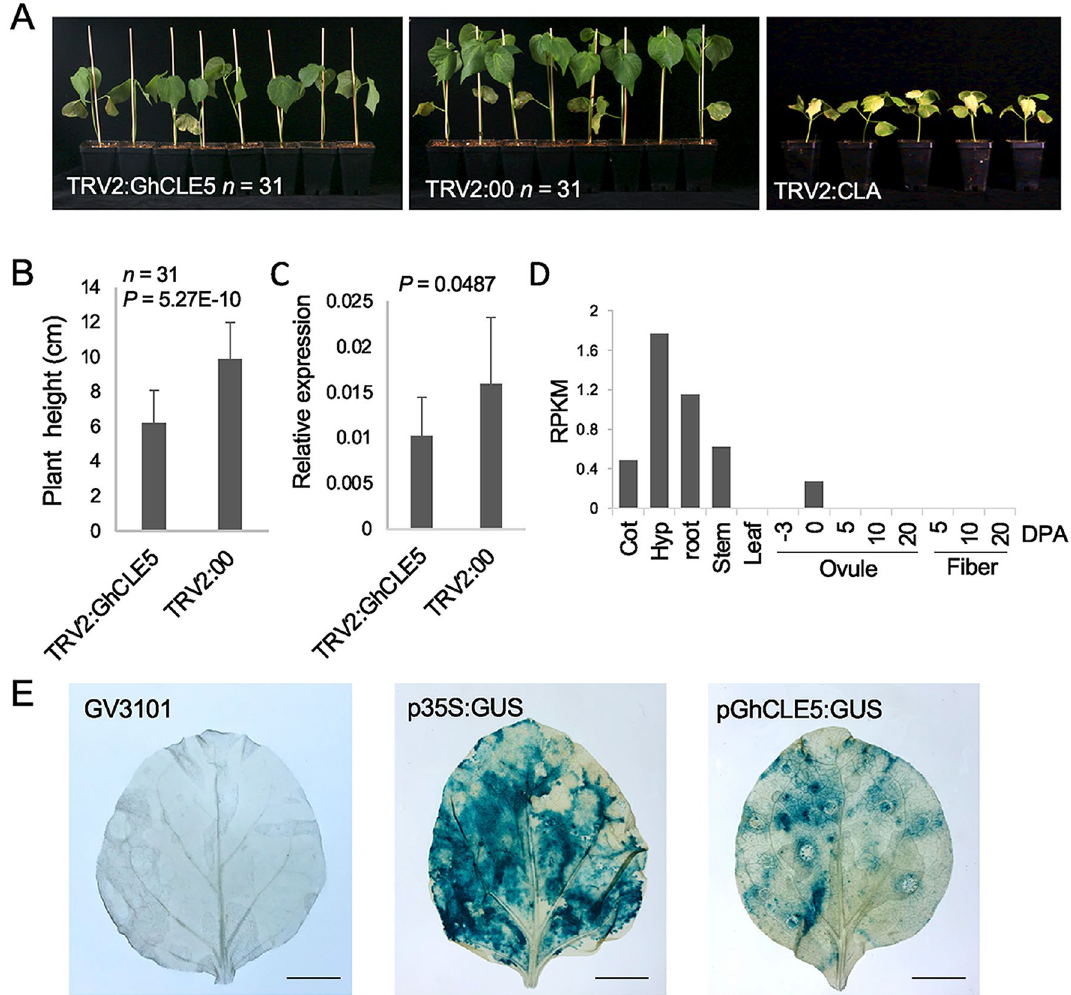
Figure 7. The phenotype of cotton seedlings following VIGS to suppress the expression of GhCLE5 . ( A ) VIGS- treated cotton seedlings. The population sizes of the pTRV2:GhCLE5 and pTRV2:00 treatments were both 31. The pTRV2:CLA was the positive control group for VIGS showing bleached leaves. ( B ) Histogram indicating the differences in plant height between the pTRV2:GhCLE5 and pTRV2:00 groups derived from the VIGS-treated plants shown in panel A (Student’s t test). Error bar = Std. ( C ) Histogram showing the relative expression of GhCLE5 in the pTRV2:GhCLE5 and pTRV2:00 groups derived from the VIGS-treated leaf tissues shown in panel A (Student’s t test). Error bar = Std. ( D ) Histogram showing the GhCLE5 expression pattern in the cotyledon (Cot), hypocotyl (Hyp), root, stem, leaf, ovule, and fiber tissues of upland cotton using RNA-seq RPKM values. DPA, days post anthesis. ( E ) The imagines show the GUS staining of the tobacco leaves transient expressed with the GUS reporter driven by GhCLE promoter (pGhCLE5:GUS). The negative control is GV3101 bacterial injection buffer with and without the pBI121 vector containing a GUS driven by 35S promoter (p35S:GUS). Three biological replicates were applied for each test group. Scale bar = 1 Evolutionary analysis and structure prediction. The screened CLE protein sequences were aligned using ClustalX (http://www.clust al.org/) with default parameters. In constructing the phylogenetic tree, Model- Generator (http://mcine rneyl ab.com/softw are/model gener ator/) software 43 was used to calculate the best alter- native model. PhyML (http://www.atgc-montp ellie r.fr/phyml /) was used to construct the phylogenetic tree with the parameters Bootstrap100 and model JTT. A Gene Structure Display Server (GSDS, http://gsds.gao-lab.org/) was used to analyze the intron–exon structure of genes.